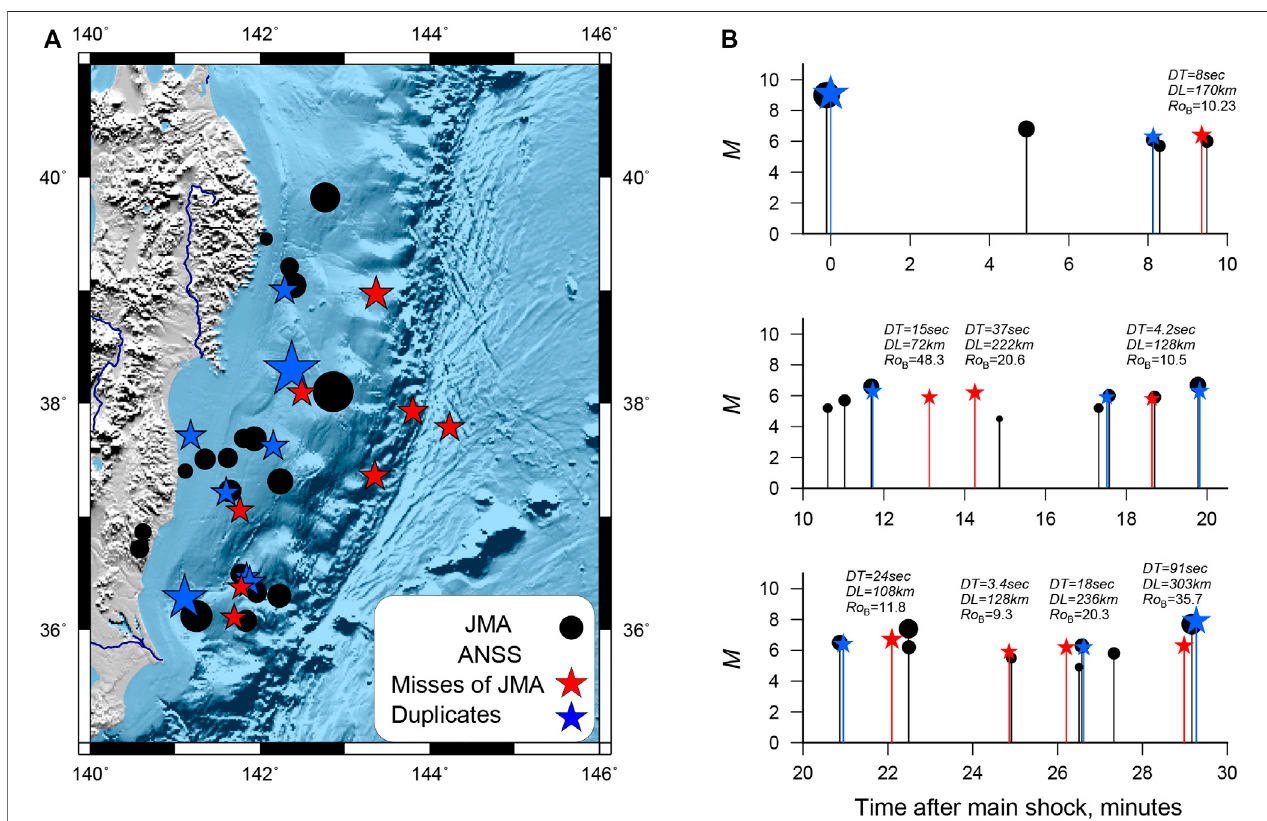
FIGURE7| EarthquakesregisteredbyJMAandANSSinthe fi rsthalfhourafterthemainshock. (A) Epicentermap. (B) SequenceofeventsJMA(black)andANSS (red — JMAmisses,blue — eventswithduplicatesinJMA)withoutmagnitudelimitations.ForeventsfromANSSmissedinJMA,thevaluesofthemetric,timeanddistance to the nearest JMA event are given. The designations are the same as in (A)